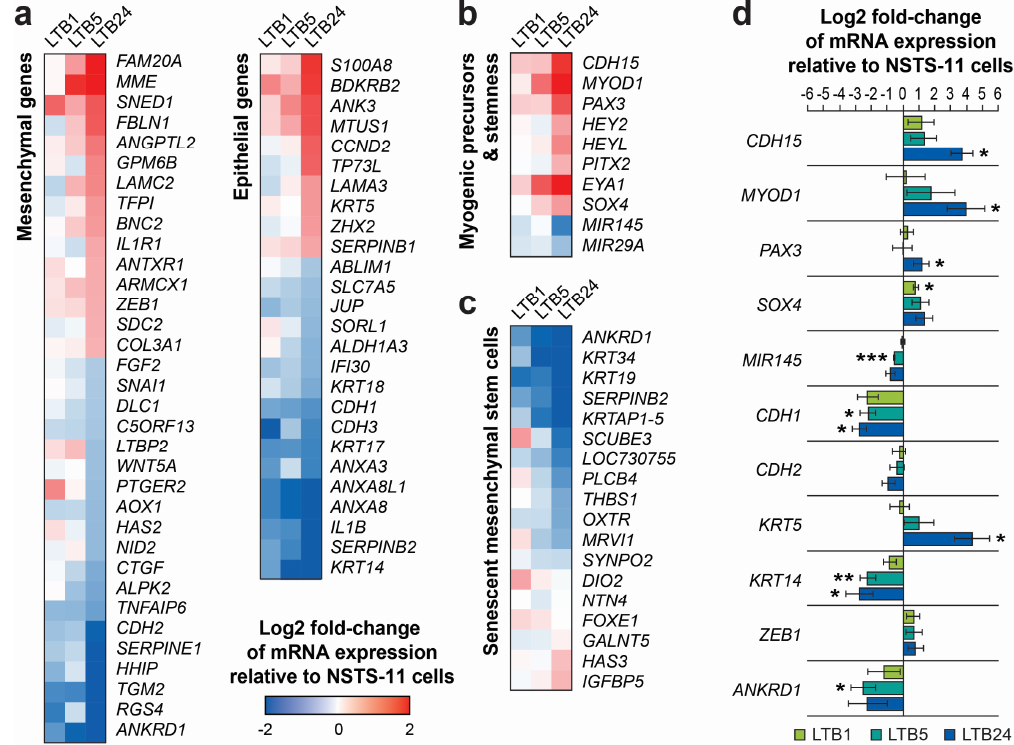
Figure 6. ( a ) Expression levels of di ff erentially expressed genes categorized based on their association with a mesenchymal or an epithelial phenotype. ( b ) Expression profile signature suggesting enhanced stemness and impaired myogenic di ff erentiation. ( c ) Expression profile of the genes that are associated with senescence of mesenchymal stem cells [25]. ( d ) qRT-PCR validation of the gene expression profiling data. The expression of all 11 genes tightly reflected the expression profile detected by microarray analysis (see a , b ). Data are presented as the mean ± SD of three biological replicates. * p < 0.05, ** p < 0.01, and *** p < 0.001 relative to parental NSTS-11 cells.